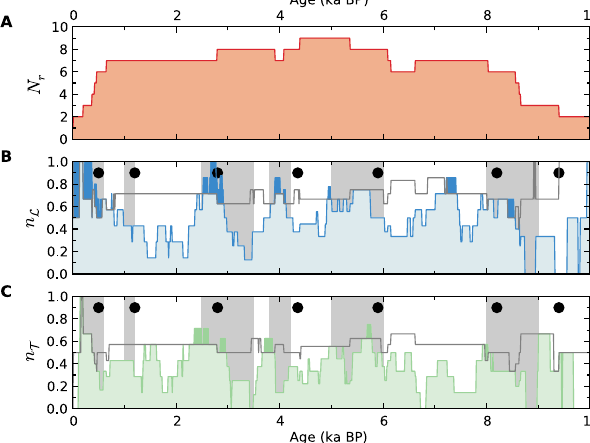
Figure 9. Summary statistics showing continental-scale monsoonal regime shifts obtained from all detrended raw palaeoclimate records (Figs. 4, 7 and 8): (a) number of records N r in this study giving in- formation on monsoon variability in each considered time interval. (b, c) Fraction of records n L (blue), n T (green) exhibiting non- typical dynamics regarding the RN characteristics L ( b , indicat- ing dynamical changes) and T ( c , indicating epochs of particular (in)stability). Epochs of significant climatic change on continental scales are marked in dark blue and dark green, respectively. Grey lines in panels (b, c) indicate the fractions of records with atypi- cal dynamics that might arise due to chance (90% confidence level; see the main text for a detailed description of the underlying signif- icance test).